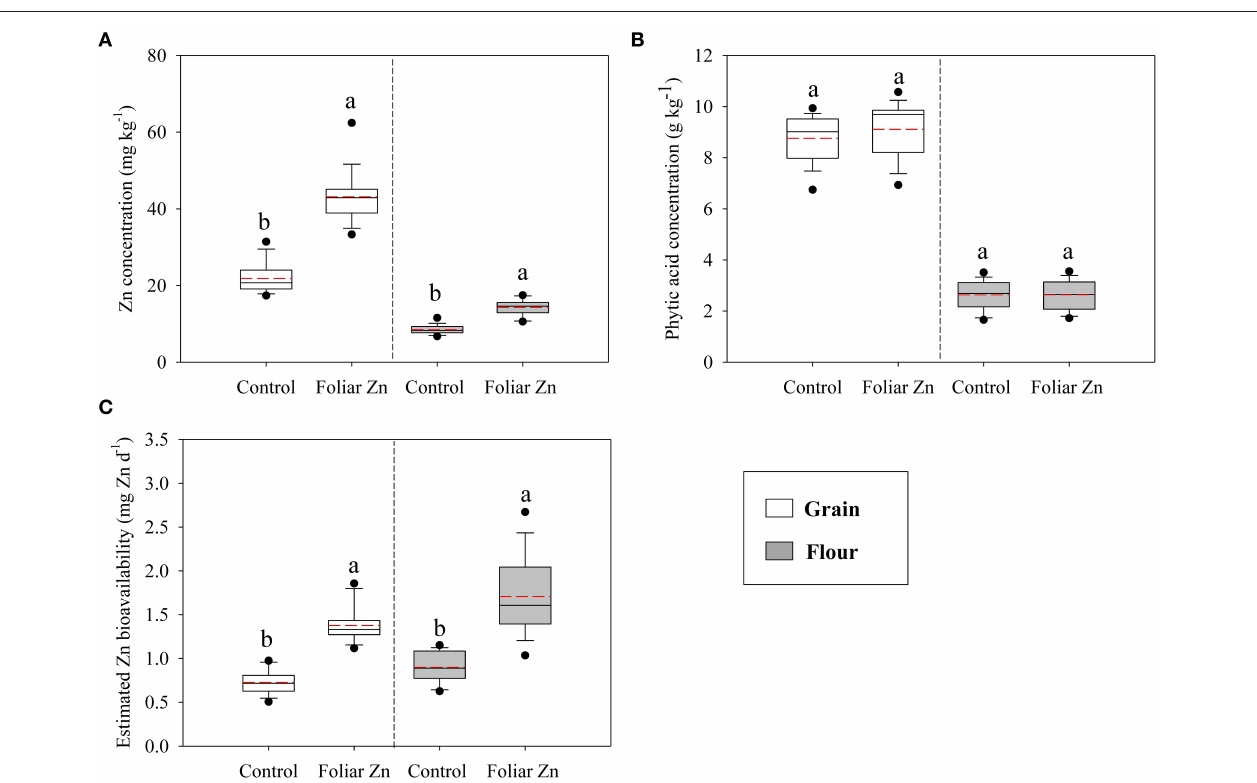
FIGURE 3 | Zinc (Zn) (A) and phytic acid (B) concentrations and estimated Zn bioavailability (C) in wheat grain and flour as affected by foliar Zn application in Quzhou County. The solid and red dashed lines indicate the median and mean values, respectively. The same lowercase letter indicates no significant difference between the foliar Zn application levels via independent t -tests at the P < 0.05 level. The rate of flour extraction was around 75%. coverage rate of Zn-biofortified wheat flour), in contrast to the self-cultivated flour or the flour purchased by rural